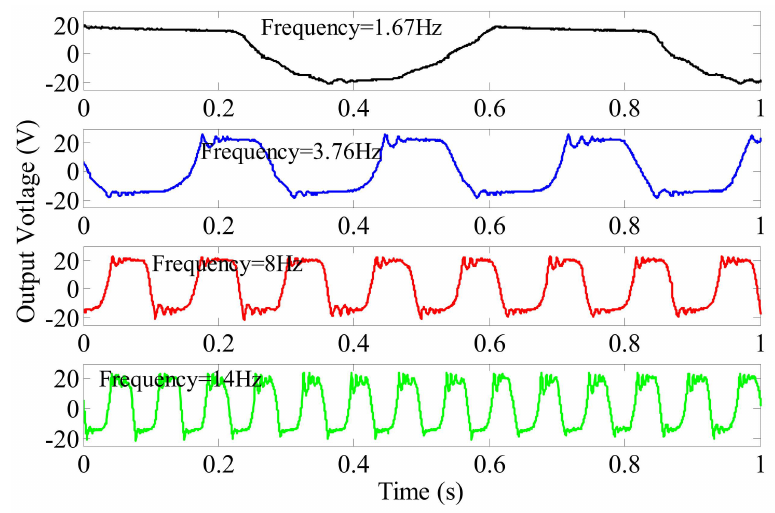
Figure 9. Piezoelectric voltage output versus